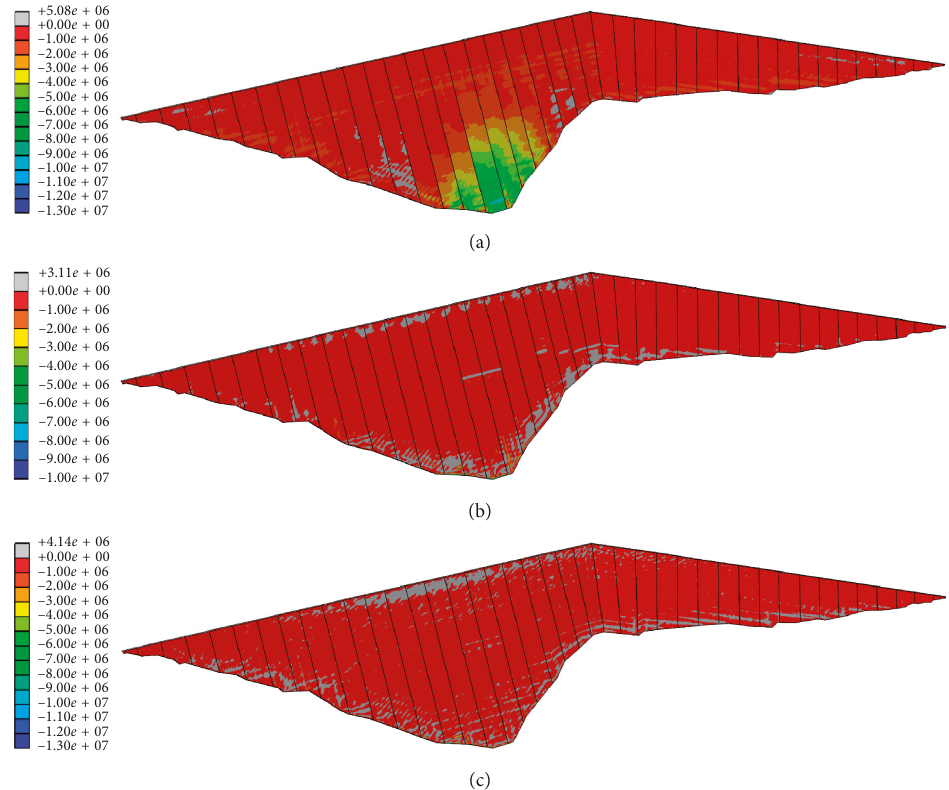
Figure 17: Stress distributions of the face slab (Pa): (a) stress along the slope (S1); (b) stress cross the slope (S2); (c) stress perpendicular to the slope